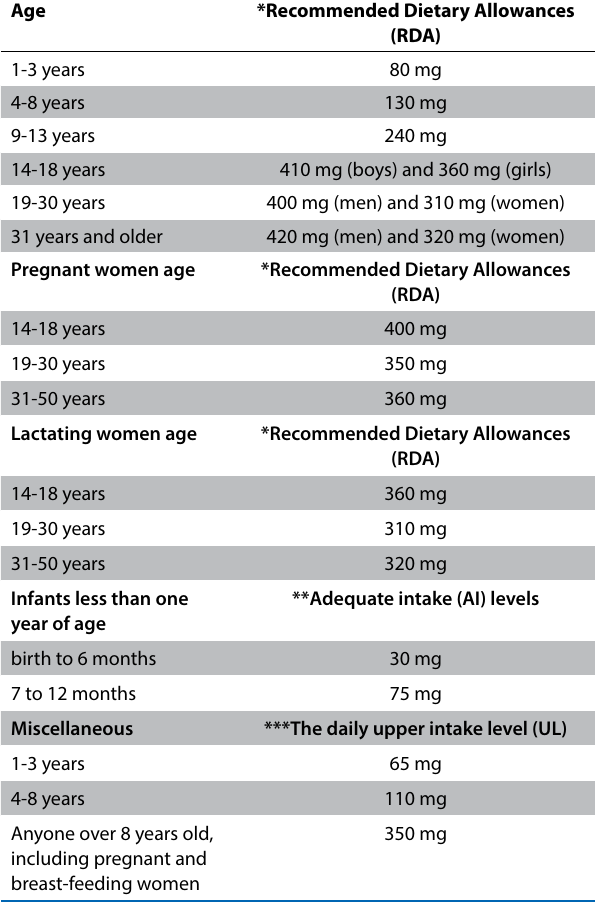
Table I: Daily Recommended Dietary Allowances (RDA) for elemental